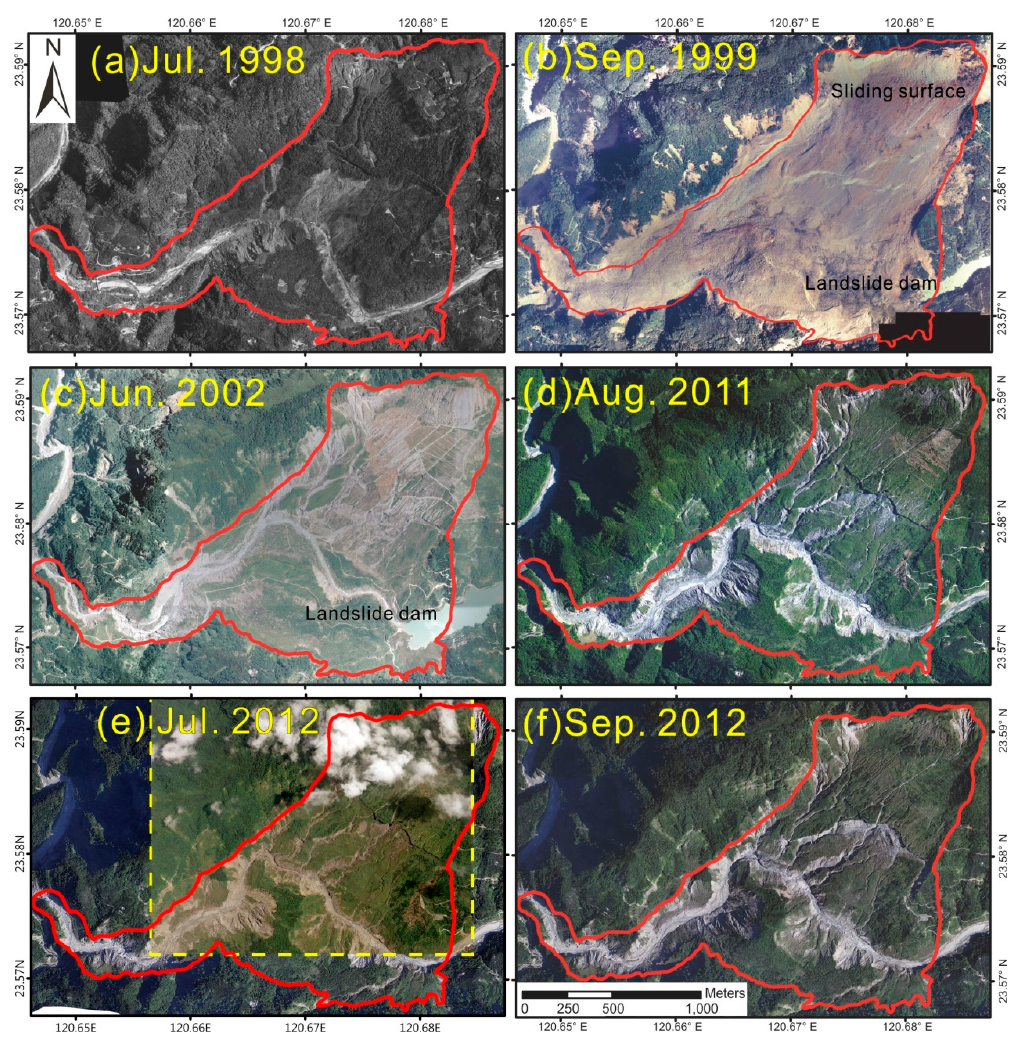
Figure 4. Orthoimages from six periods with a pixel resolution of 25 cm from 21 July 1998, 24 September 1999, 21 June 2002, 26 August 2011, 1 July 2012, and 17 September 2012 used in the study for topographic feature interpretation. The red outline shows the Tsaoling landslide area. ( a ) The Tsaoling region before the Chi-Chi earthquake; ( b ) An image taken several days after the earthquake, showing the Qingshui River affected by the landslide and the formation of a landslide dam; ( c ) An image taken two years after the earthquake, during which the landslide dam still existed; ( d ) An image taken in 2011, 12 years after the earthquake, when the landslide dam had disappeared; ( e ) A superimposed image, used to observe the change in position of the Chunqui Cliff, where only the part highlighted by yellow dashed line was taken in July 2012; ( f ) An image taken in September 2012.